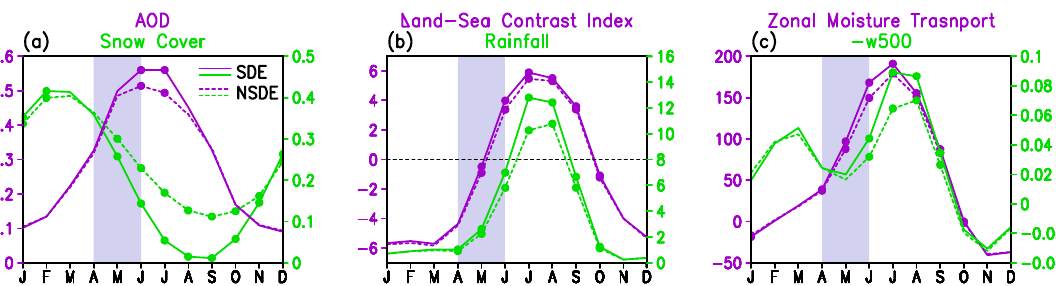
Figure 7. Time series depicting the seasonal cycles of ( a ) snow cover (percentage) and AOD, ( b ) land–sea contrast ( ◦ C) and rainfall (mm day − 1 ) over northern India (70–90 ◦ E, 25–35 ◦ N), and ( c ) westerly low-level (1000–850 hPa) moisture flux (Kg m − 1 s − 1 ) averaged over the eastern Arabian Sea (70–75 ◦ E, 10–30 ◦ N) and negative p-velocity (Pa s − 1 ) over northern India. Domains for snow cover and AOD are the same as used in Figure 1. Labels and ordinate units are color-matched to the line plot.